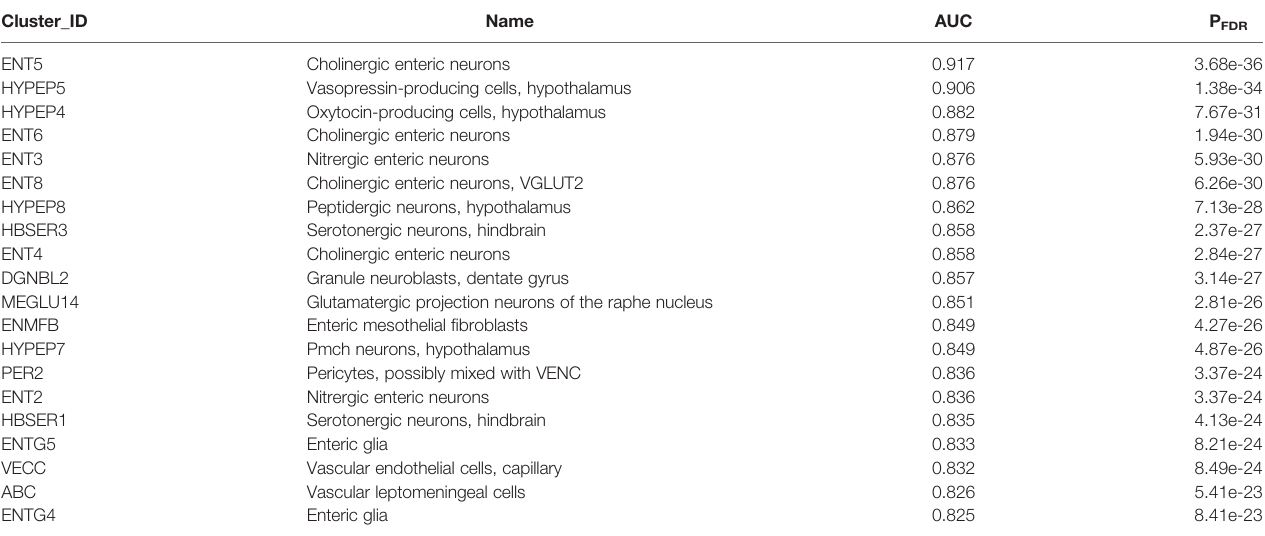
TABLE 4 | Top 20 transcriptomic cell type clusters enriched for higher expression of the ER translocation genes. Cluster_ID